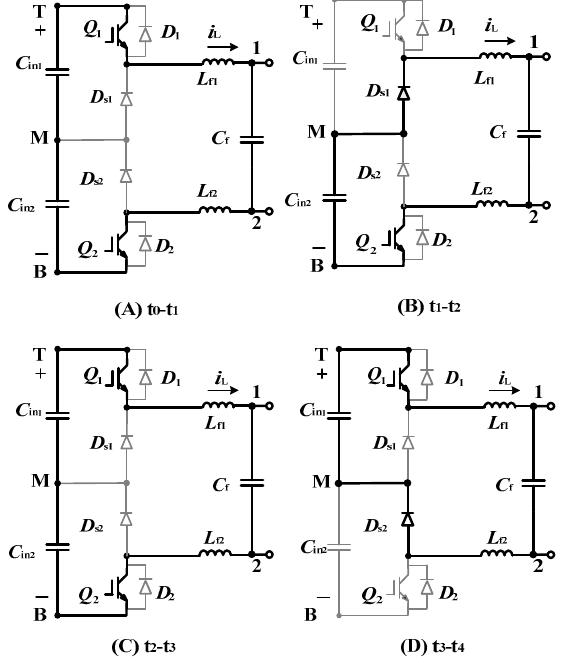
Figure 5. Operating stages and equivalent circuits for D > 0.5.